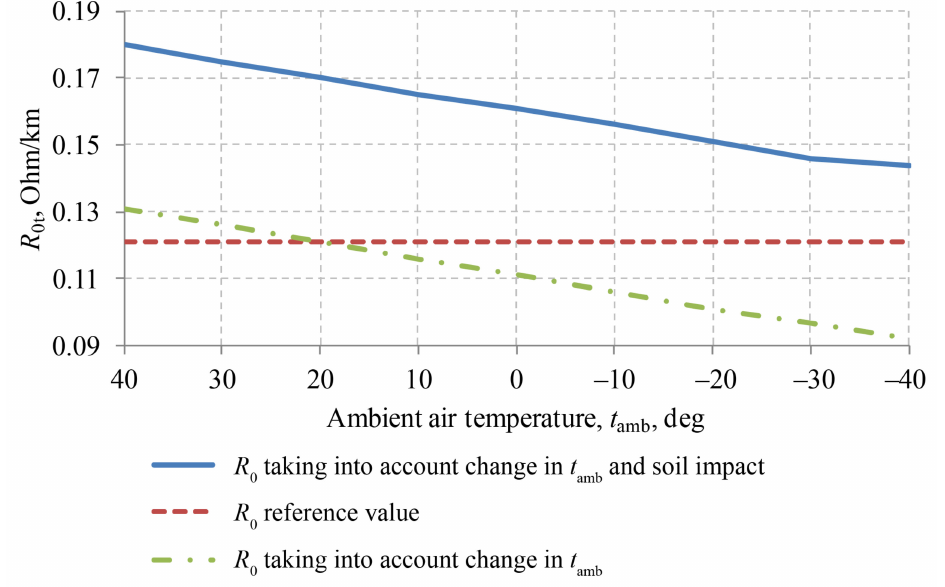
Figure 11. Change in the total linear resistance of the wire as a function of the ambient temperature, taking into account the final conductivity of the